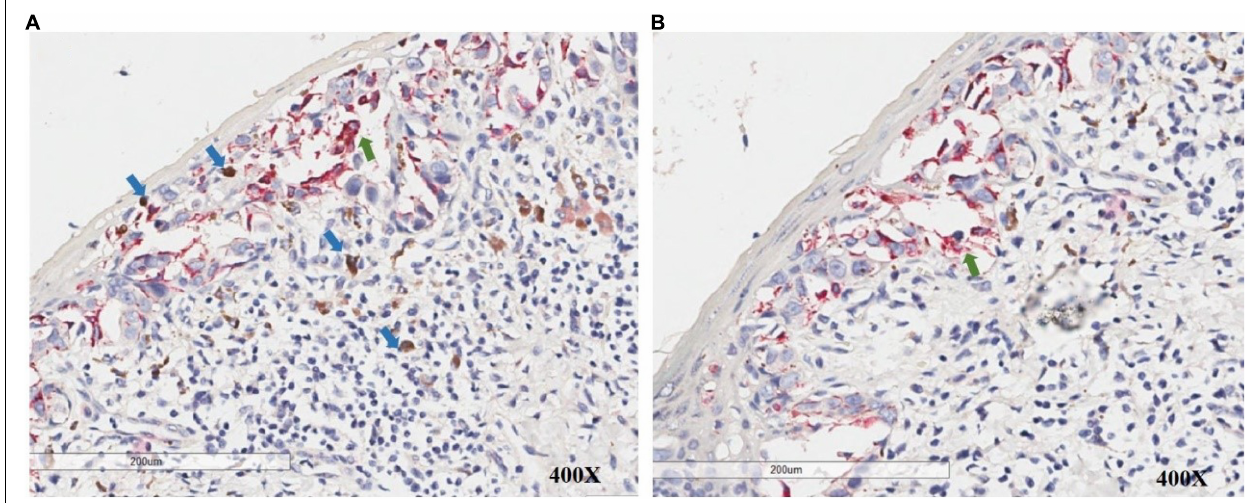
FIGURE 3 | PHH3/Melan-A dual staining allows accurate discrimination of melanocytes (green arrow) and adjacent mitotic figures in non-melanocytes (blue arrow) in the intraepidermal/junctional and dermal area.